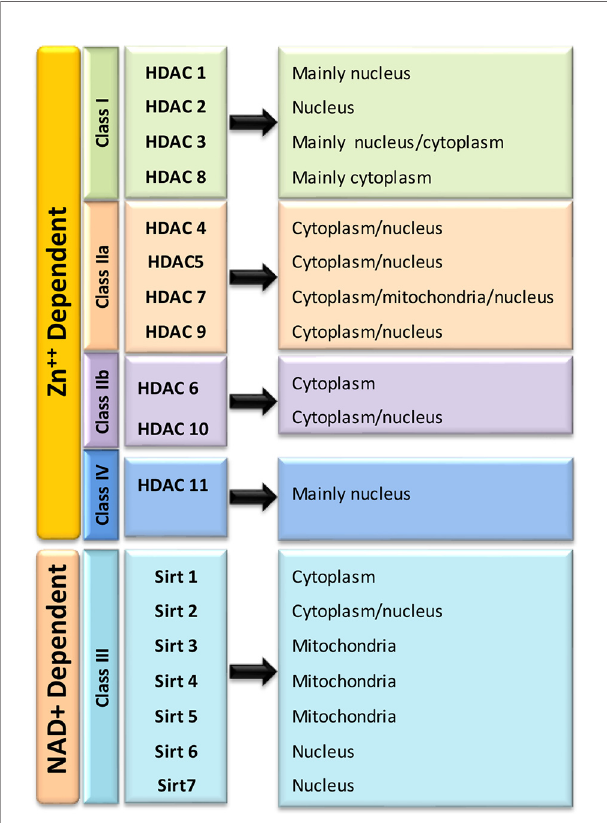
FIGURE 3 | Classi fi cation of Histone Deacetylases (HDACs) and their cellular